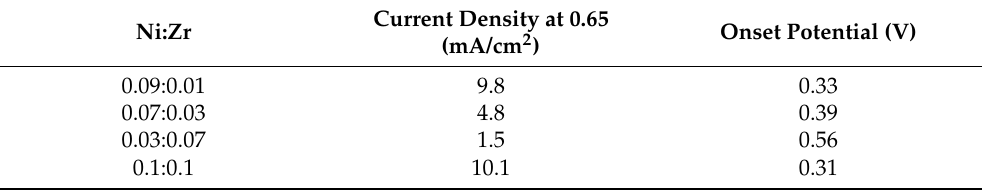
Table 5. Current density values of different Ni: Zr concentration thin films at the specified potential.